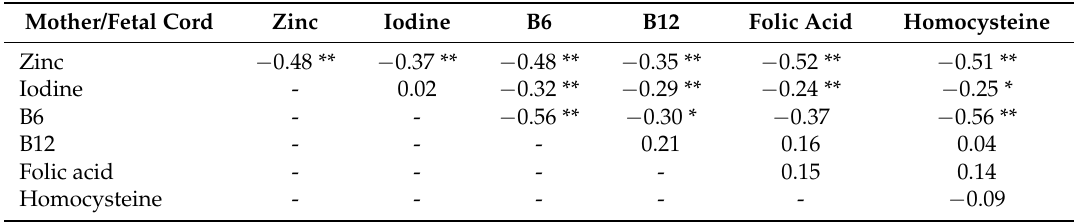
Table 5. Correlations between maternal and fetal micronutrient